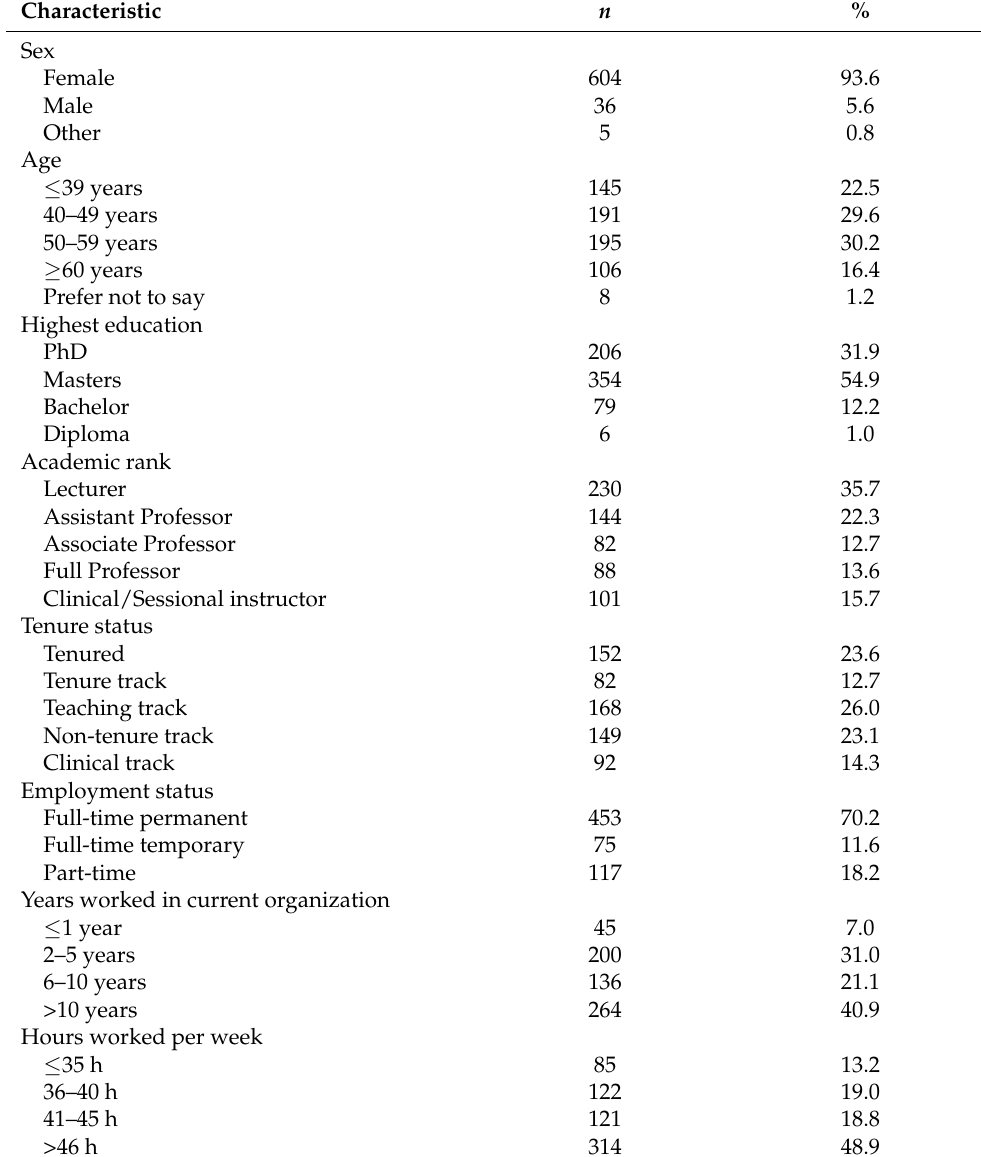
Table 1. Frequencies for faculty demographic